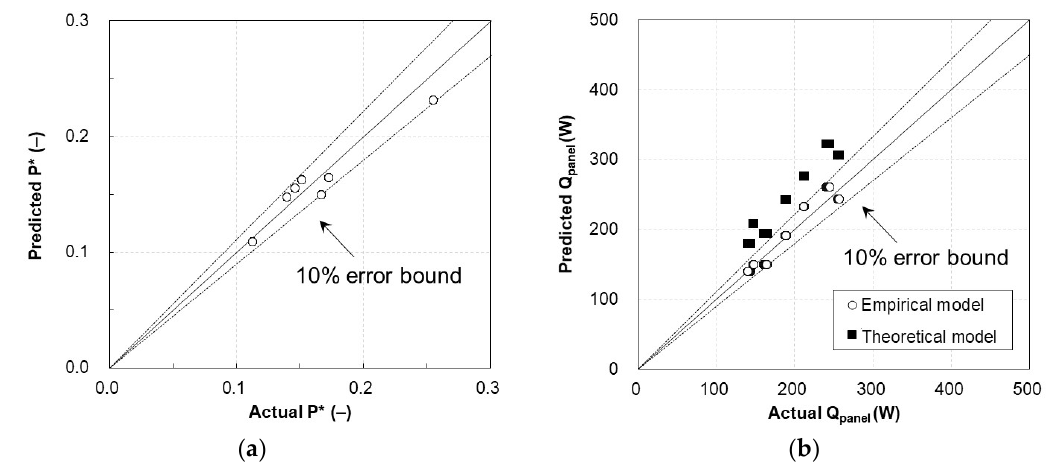
Figure 10. Validation experiment results of the TERP in the heating mode: ( a ) energy consumption of the TERP and ( b ) heating capacity of the TERP.